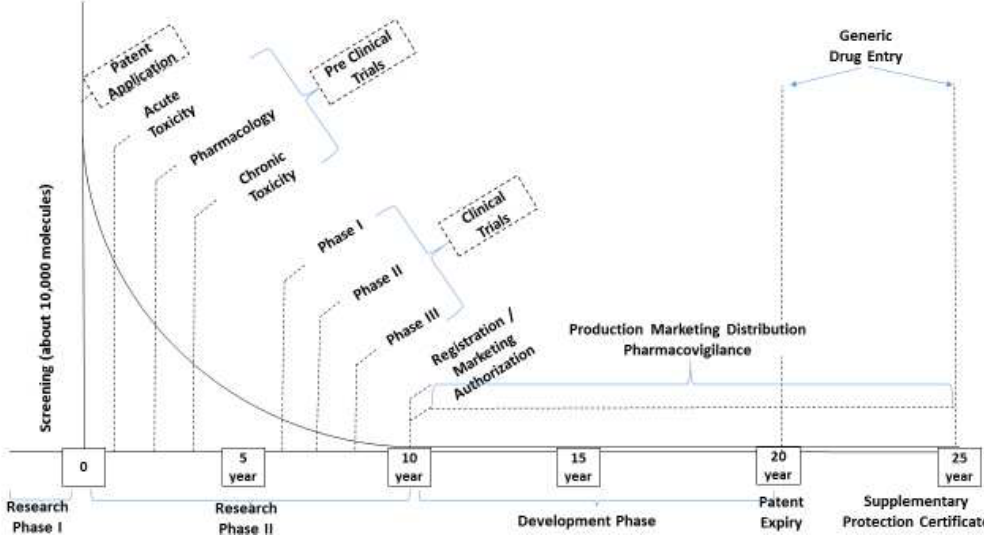
Figure 4: Phases of the New Drug R&D